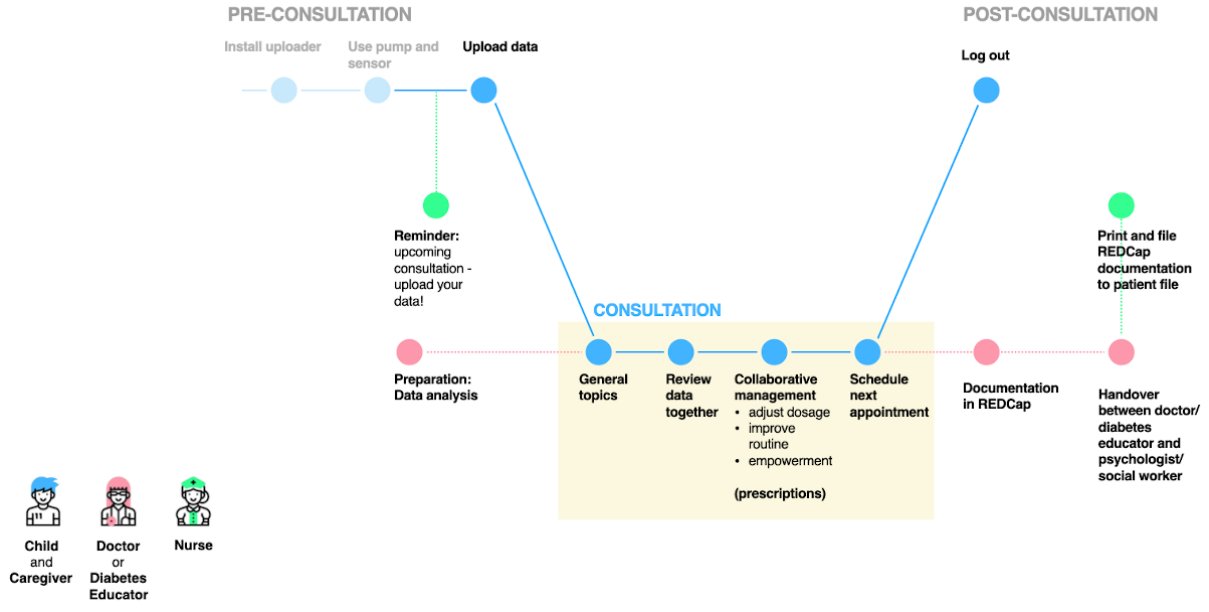
Figure 3. The "future" patient journey and the workflow of remote monthly check-ins. REDCap: Research Electronic Data